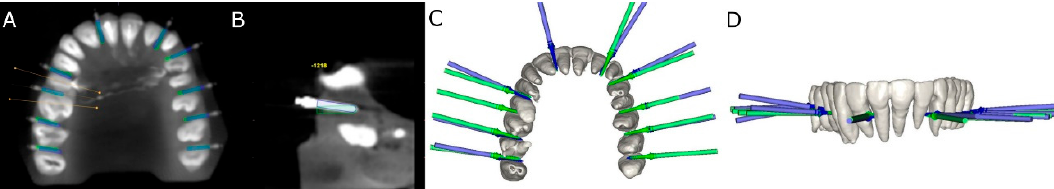
Figure 2. ( A – D ) Deviations measurement procedure between planned (green cylinder) and performed (blue cylinder) orthodontic micro-screws in the computer-aided static navigation technique study group.